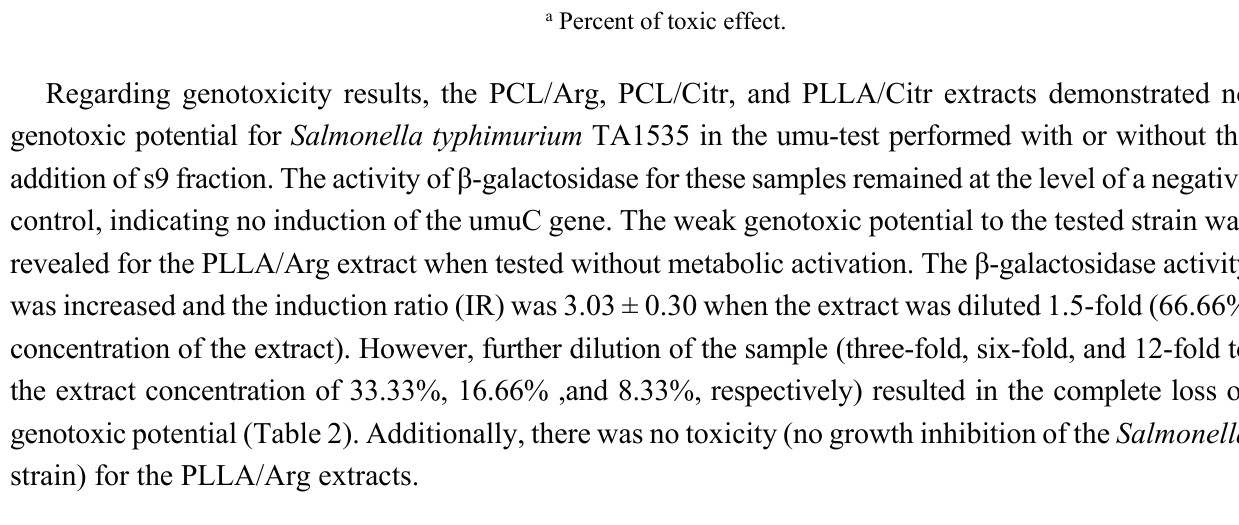
Table 2. The IR value determined for the PLLA/Arg